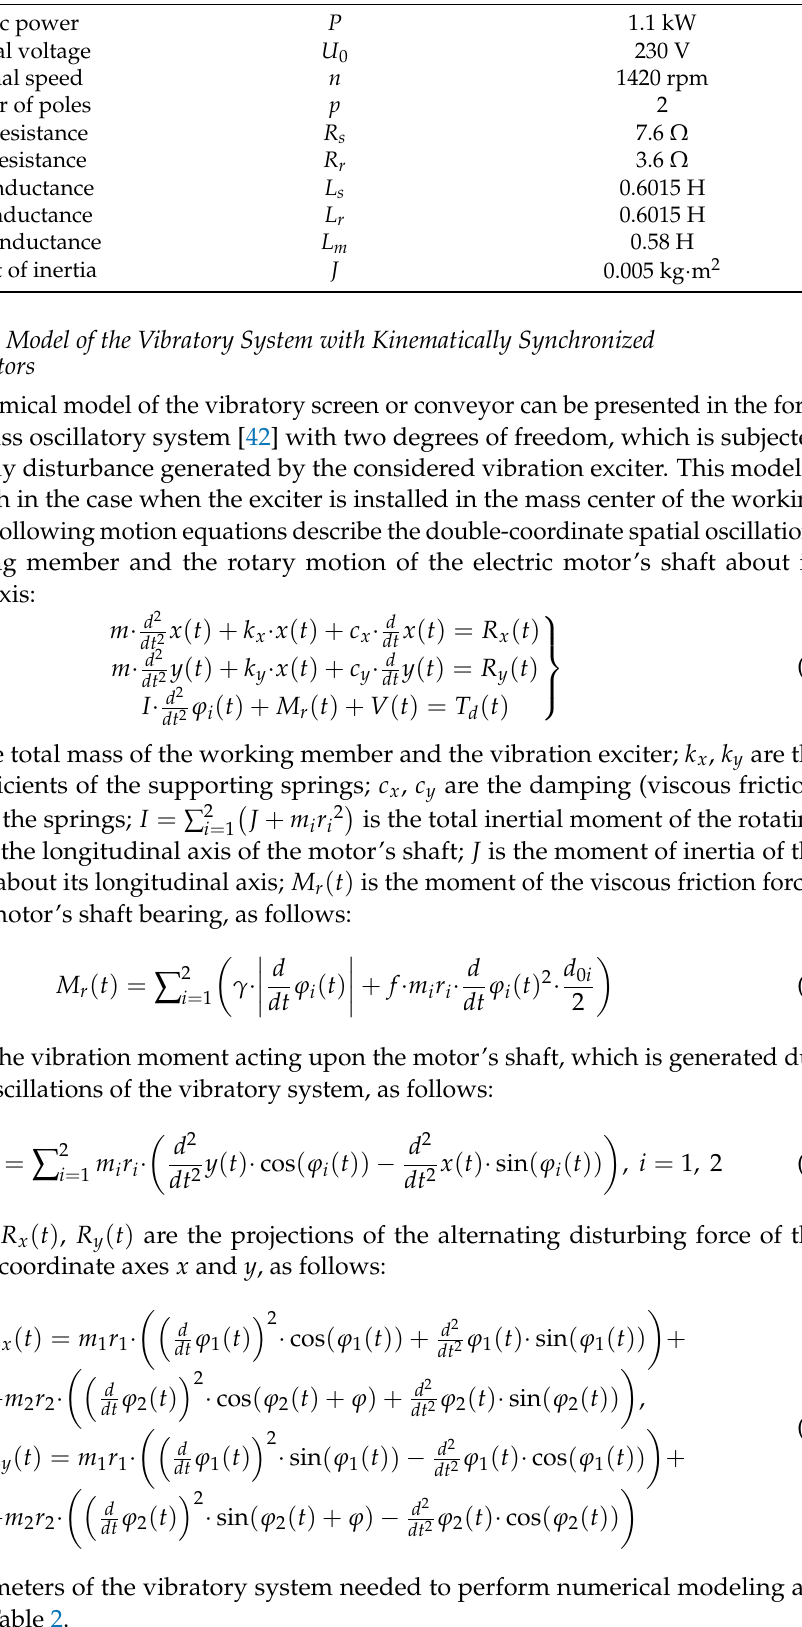
Table 1. Technical characteristics of the asynchronous electric motor [41].